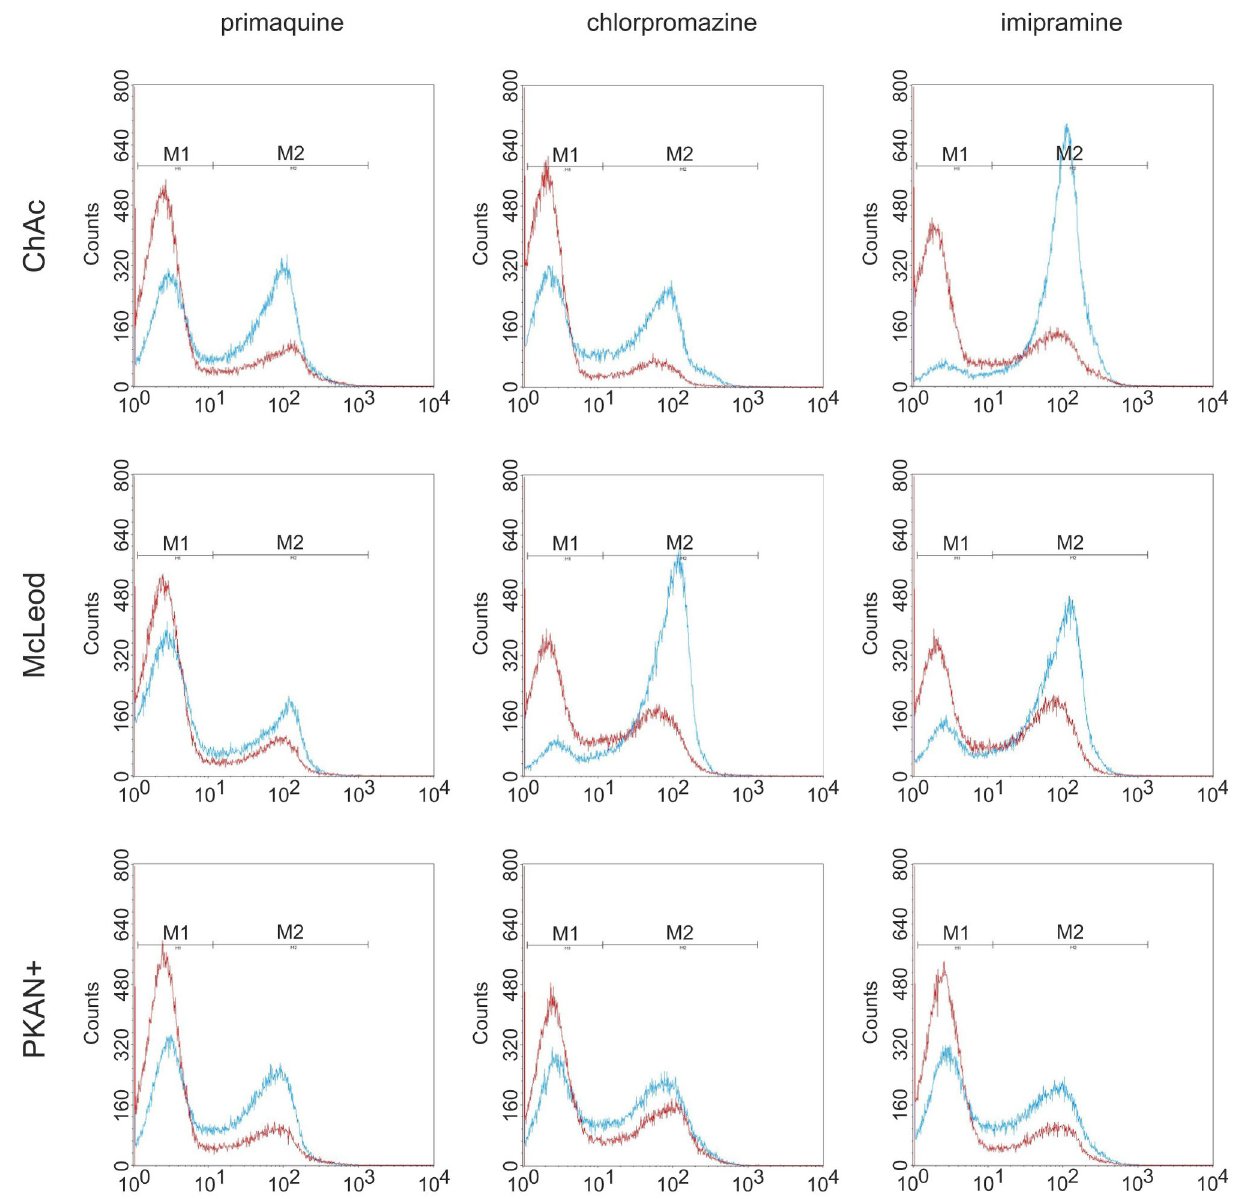
Figure 3. Altered drug-induced endovesiculation of erythrocytes from neuroacanthocytosis patients. ChAc, McLeod and PKAN+, as well as control erythrocytes were subjected to drug-induced endovesiculation using 1.5 mM primaquine, 0.4 mM chlorpromazine and 0.75 mM imipramine. The uptake of FITC-labeled dextran was determined by flow cytometry. Overlays of representative histograms of patients (red) and respective control samples (blue) clearly indicate an impaired ability of the patient’s erythrocytes to form